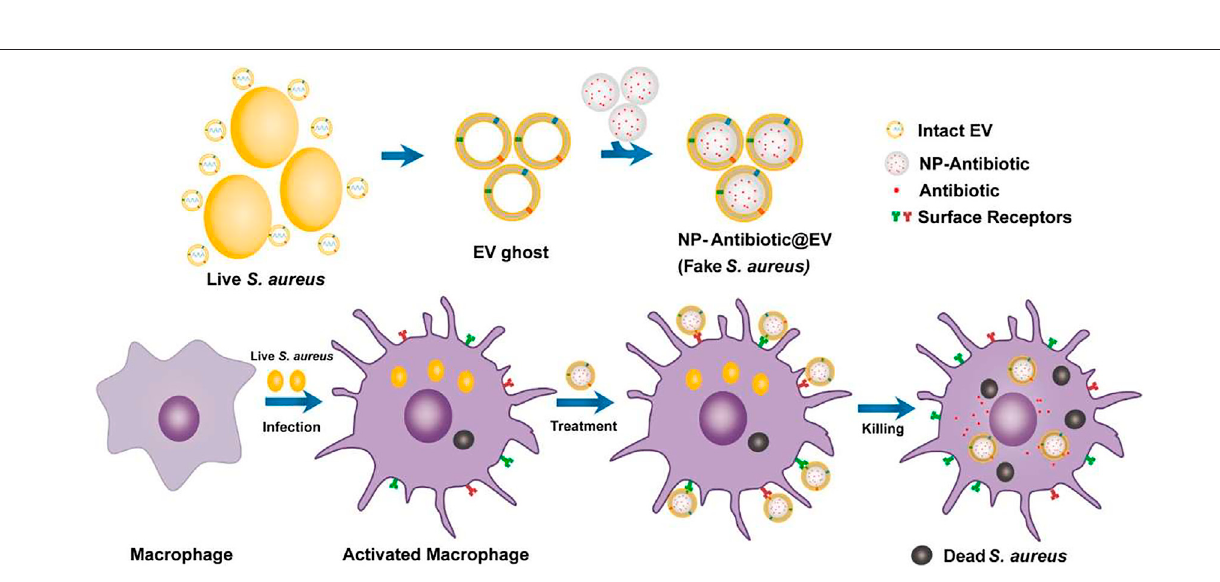
Frontiers in Chemistry |